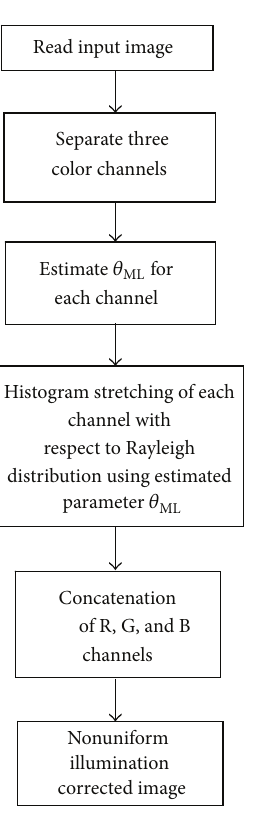
Figure 2: Process of proposed algorithm.